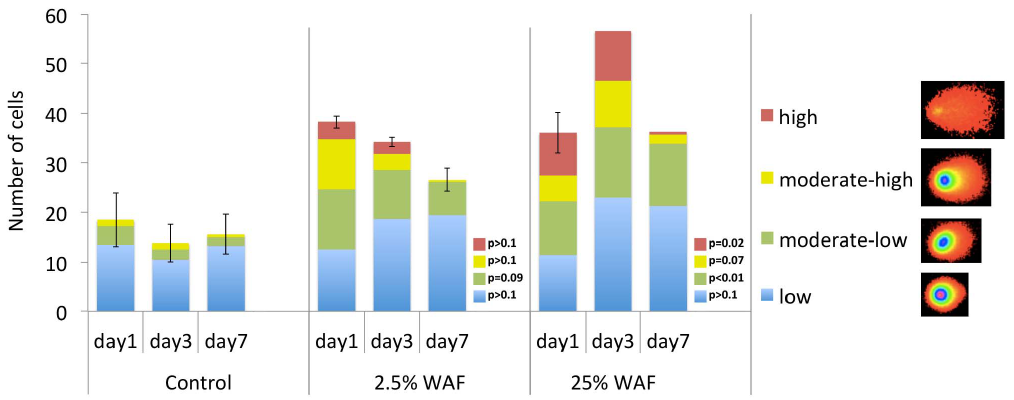
Figure 2. DNA strand breakage (comet assay) after 1 day, 3 days, and 7 days exposure to a control treatment, a 2.5% WAF treatment, and a 25% WAF treatment. Stacked bars represent the average number of cells showing strand breakage within each of four categories of severity (low, moderately-low, moderately-high, and high DNA damage as assessed by tail moment) for each treatment and time point. Comet images are representative of each category of damage. P-values are indicated for results from post-hoc tests that compare treated to control samples across all days within each severity level. Results from post-hoc tests indicate that, relative to control, DNA damage was elevated in the 25% WAF treatment, especially for high levels of damage.